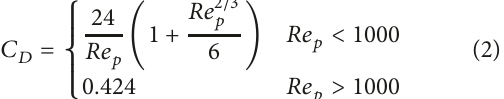
shows the particle size distribution. Note that the particle size distribution of biomass is much wider than that of